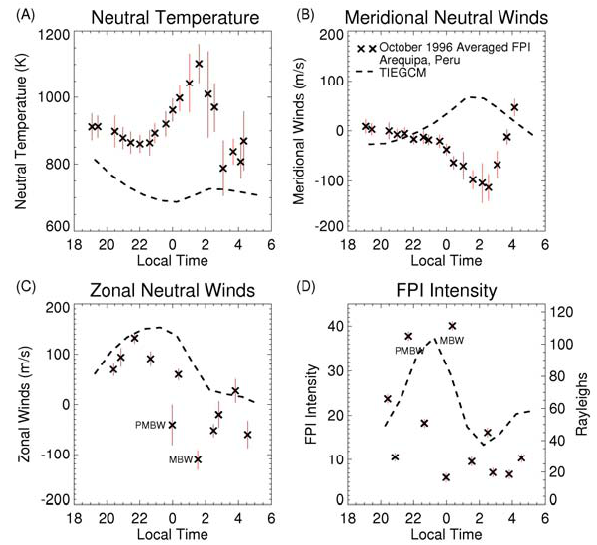
Fig. 5. A comparison between October 1996 averaged FPI measure- ments taken from Arequipa (the x’s) and the equivalent TIEGCM modeled parameters (the dashed lines) at 17.5 ◦ S latitude under sim- ilar geophysical conditions; equinox, solar minimum, magnetically quiet. (A) Neutral temperature, (B) Meridional neutral winds. Posi- tive values indicate northward winds. (C) Zonal neutral winds. Pos- itive values indicate eastward winds. (D) FPI intensity. Left-side axis denotes FPI intensity. Right-side axis denotes